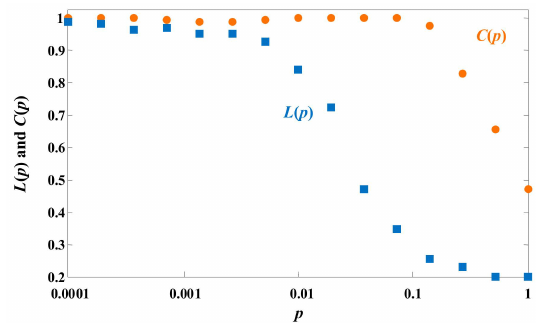
Figure 5. L ( p ) and C ( p ) for the four-hidden-layer DSWNN described in Figure